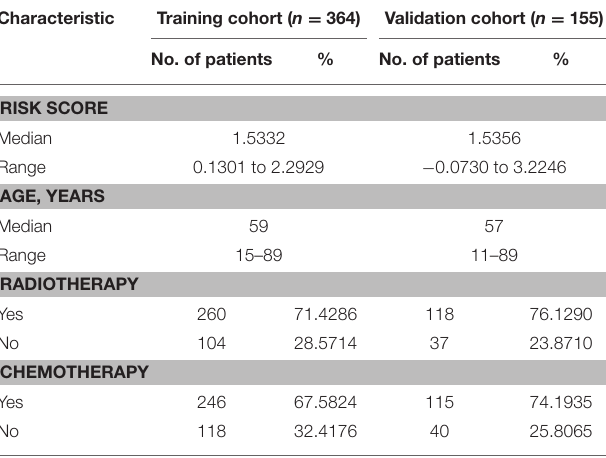
TABLE 1 | Demographics and clinicopathologic characteristics of patients in training cohort and validation cohort.